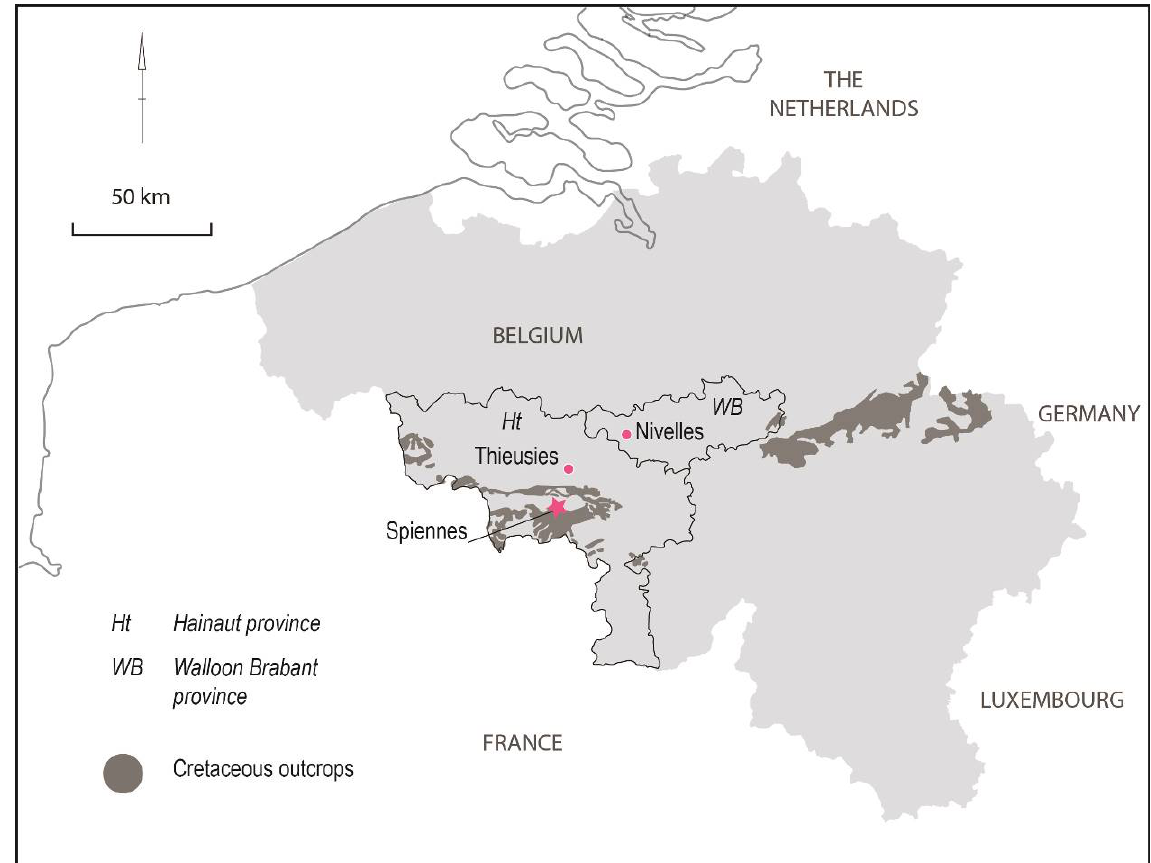
Figure 1. Location of Spiennes (Hainaut Province,